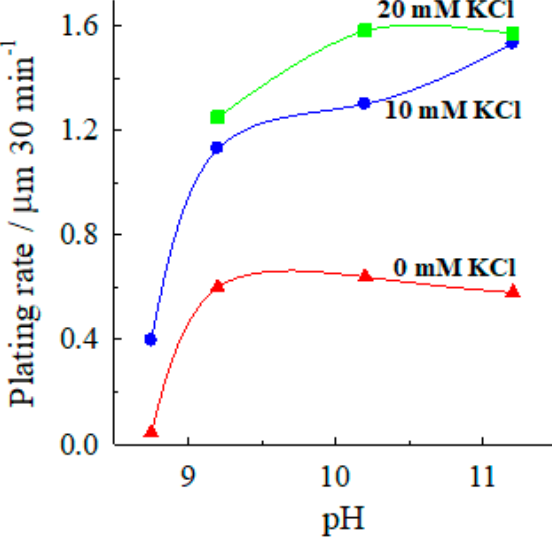
Figure 3. Dependence of the silver deposition rate on the solution pH at various chloride concentrations. Solution composition (M): AgNO 3 —0.04, CoSO 4 —0.10; (NH 3 + NH 4+ )—4; 20 °C.